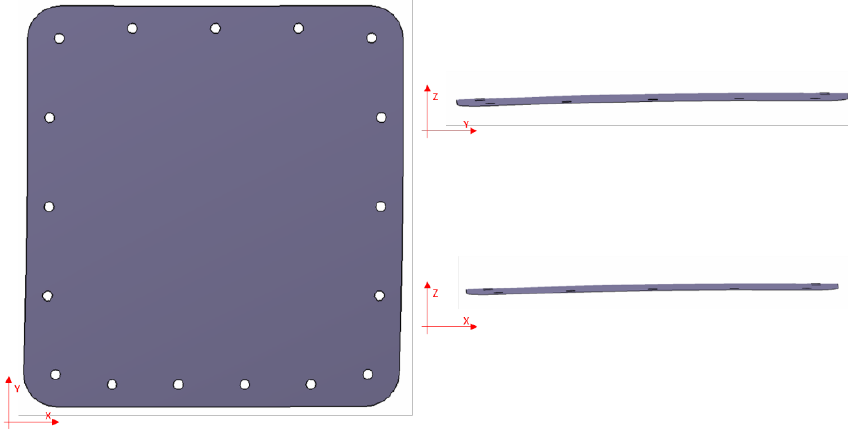
Figure 1. Design of UNS A92024-T3 aluminum alloy hydroformed Part 1.